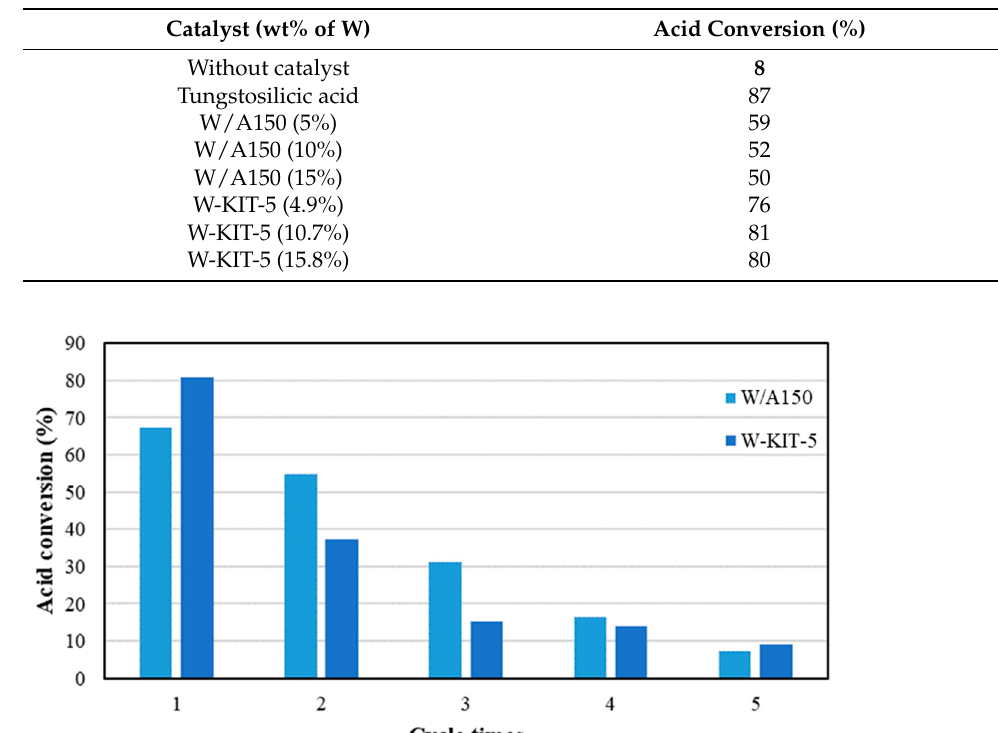
Figure 5. Reusability of the catalyst.